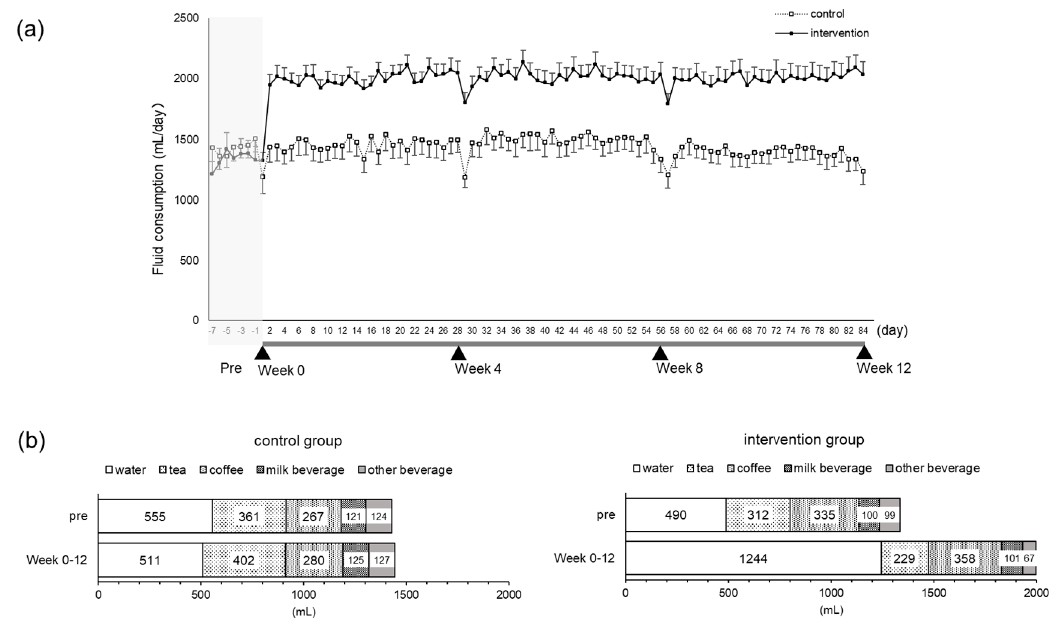
Figure 2. Daily fluid intake. Total daily fluid intake from the pre-observation period to the end of the test period. The dotted line indicates the control group. The solid line shows the intervention group. Mean ± SEM ( a ). The mean amount of each kind of fluid intake during the pre-observation period and the test period (Week 0 to Week 12) ( b